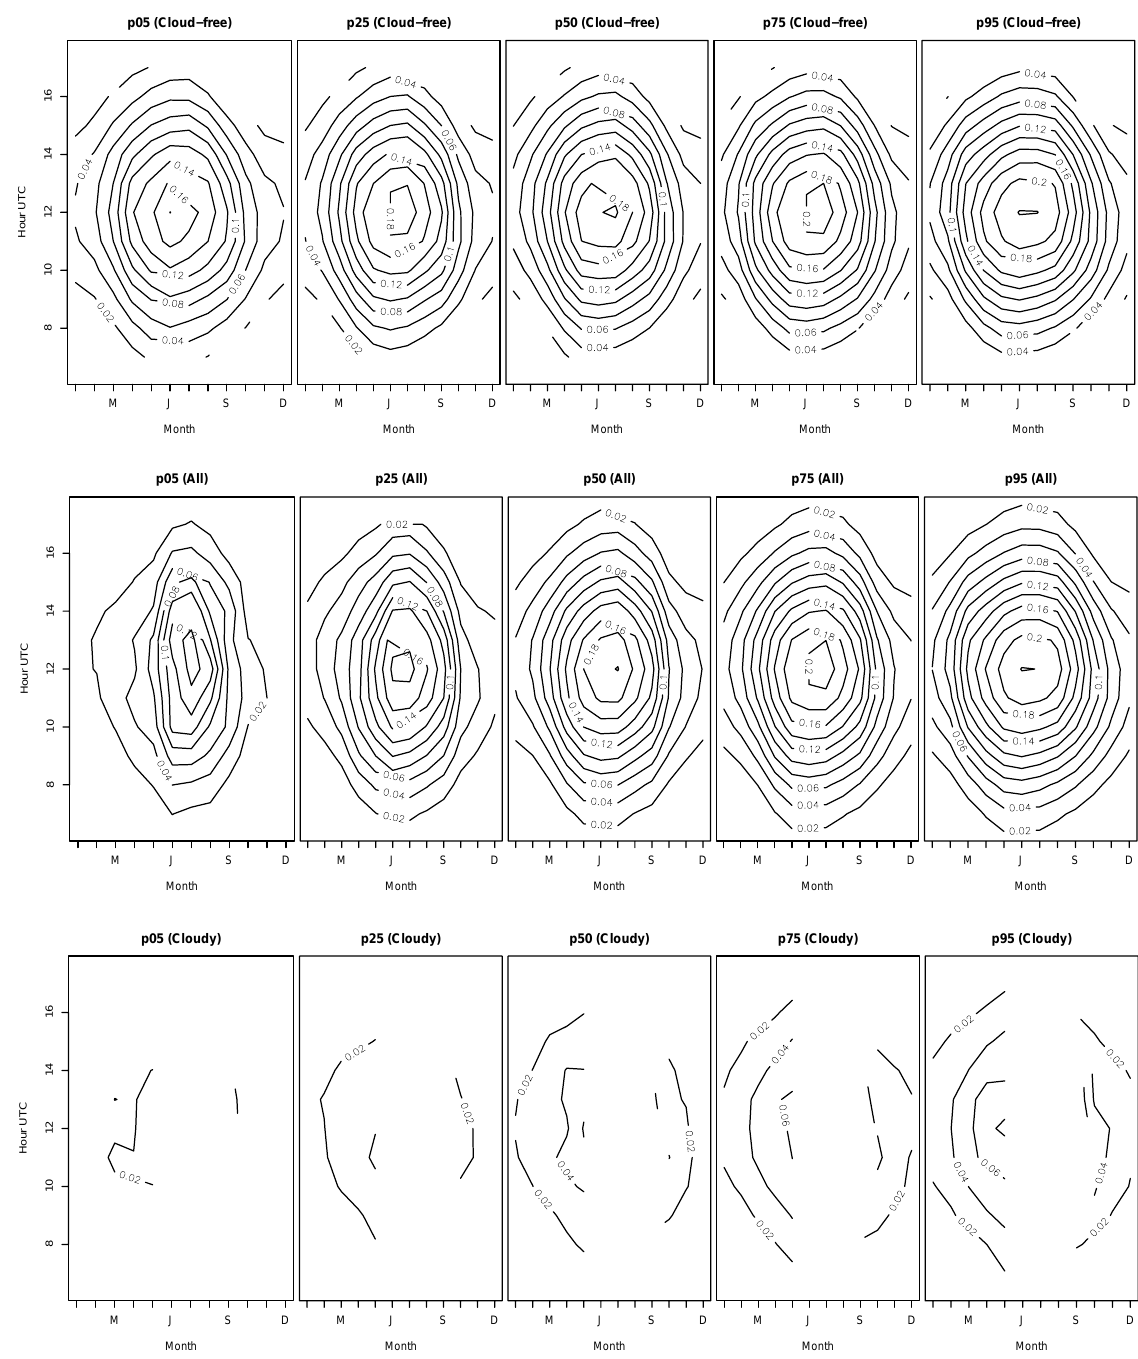
Fig. 10. Iso-irradiance lines of percentiles 5, 25, 50 (i.e. the median), 75 and 95 of hourly ultraviolet erythemal irradiance (in Wm − 2 ) under cloud-free, all weather, and cloudy